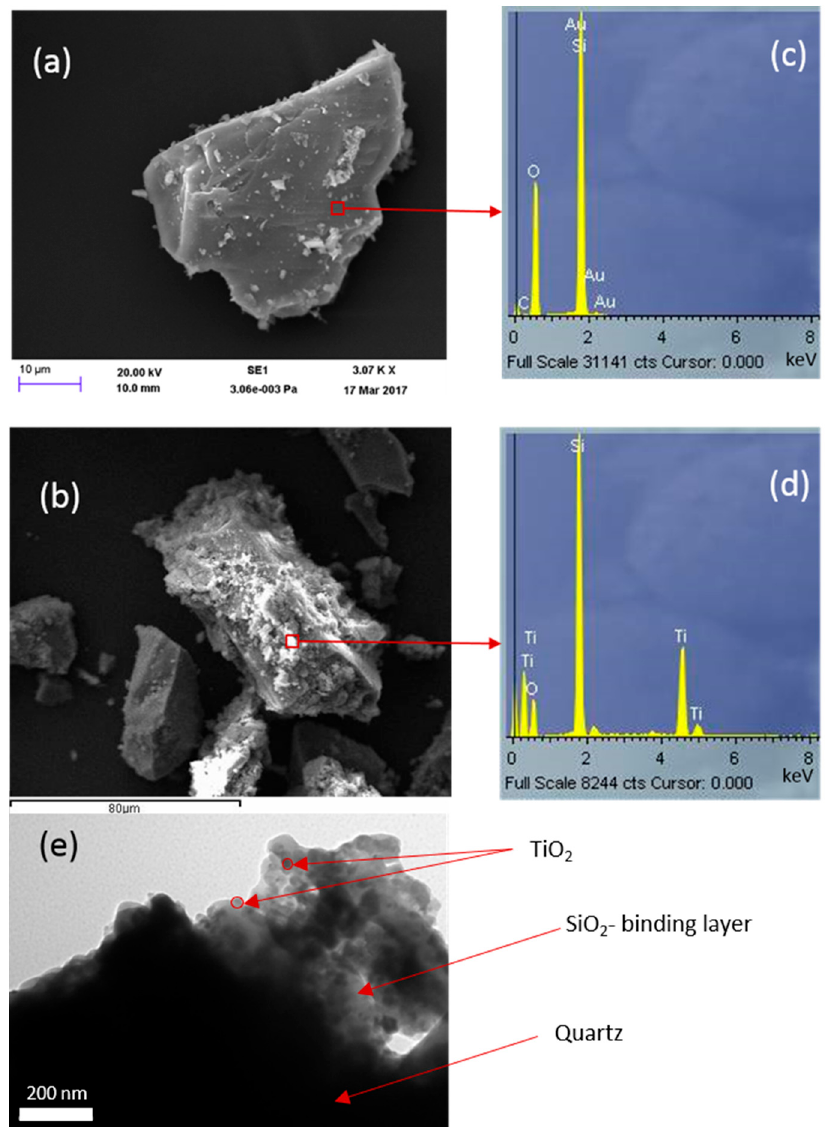
Figure 5. SEM images for ( a ) uncoated quartz and ( b ) TiO 2 (commercial PC105) immobilized on quartz via a SiO 2 binder formed from tetraethyl orthosilicate (TEOS). EDS of these samples are presented in ( c , d ), and the TEM image for the same samples in ( e ).